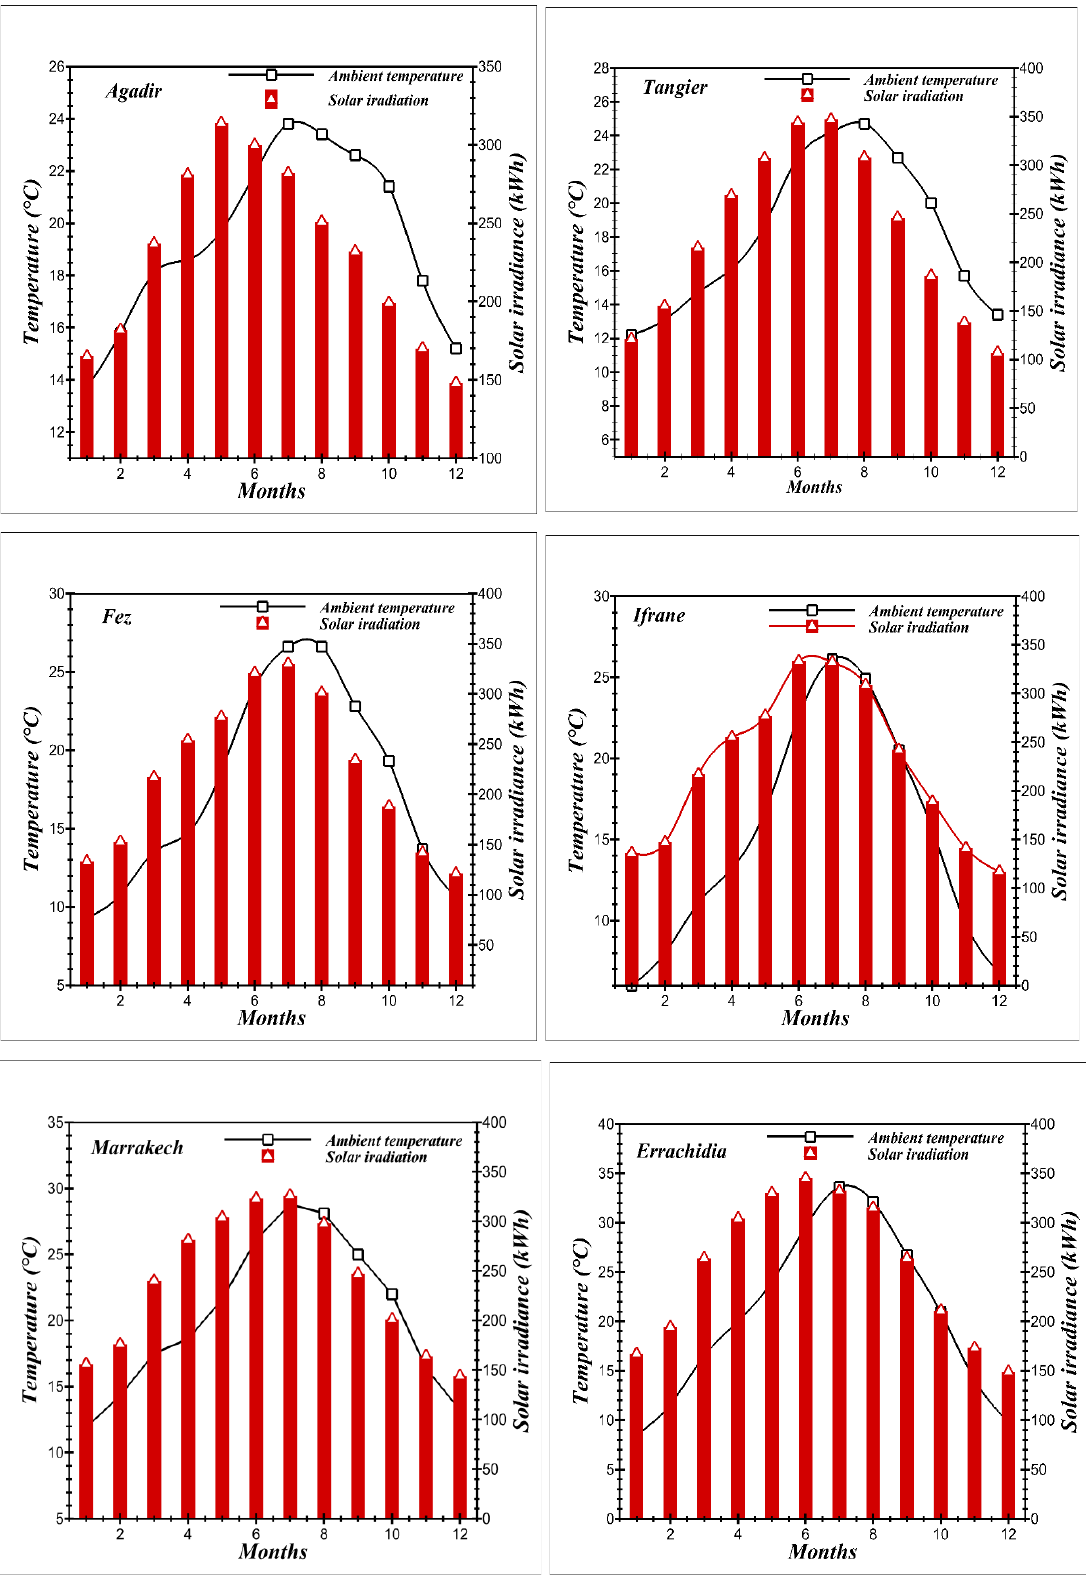
Figure 9. Weather Figure 9. Weather data.